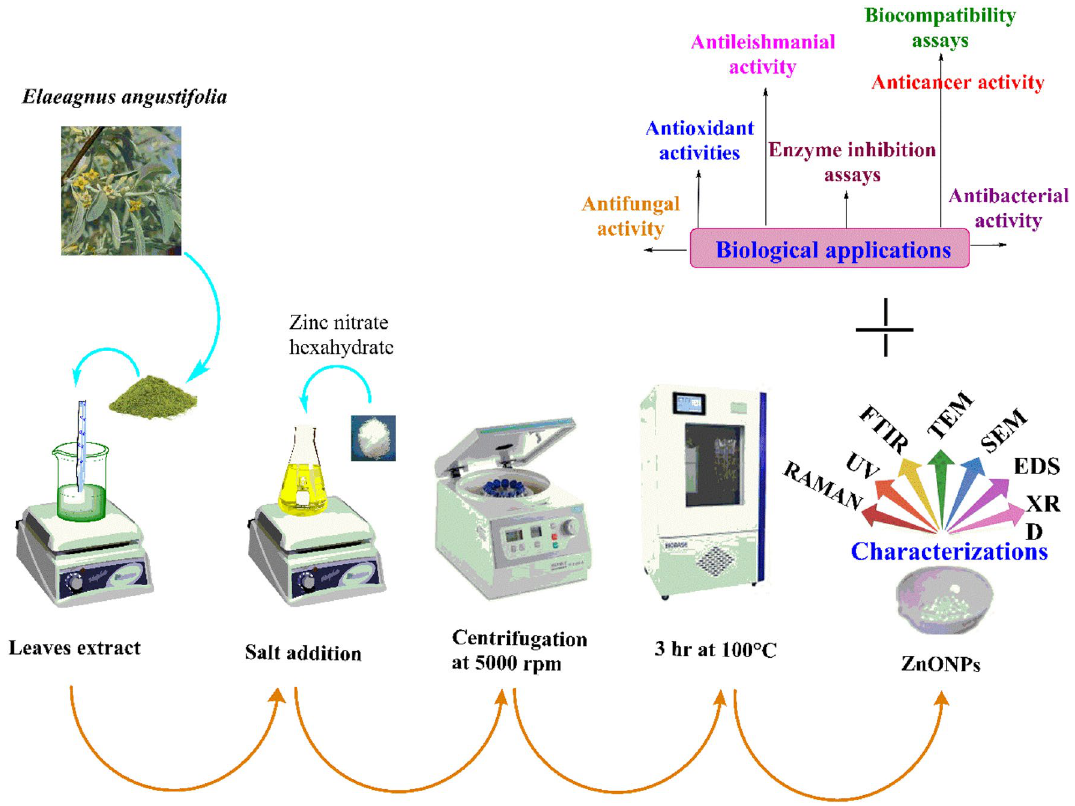
Figure 8. Study scheme depicting synthesis, characterization and biological applications of